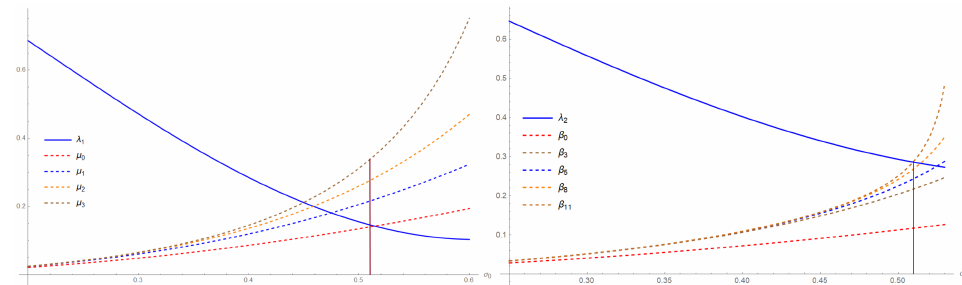
Figure 2. Comparison between criteria (13) and